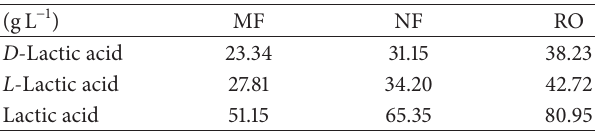
Table 3: Concentration of lactic acid by filtration